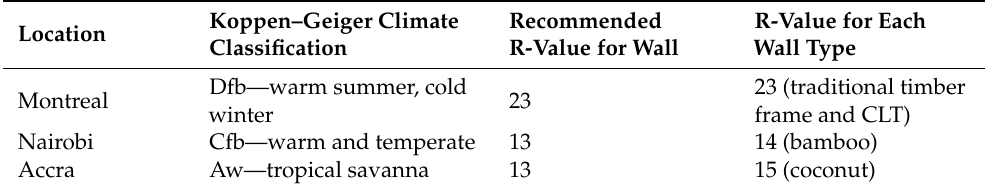
Table 5. Location, climate classification, and the associated recommended R-value for the wall construction in the three locations of